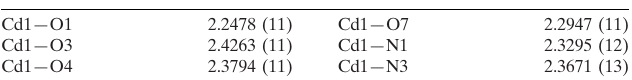
Selected bond lengths (A˚ ).